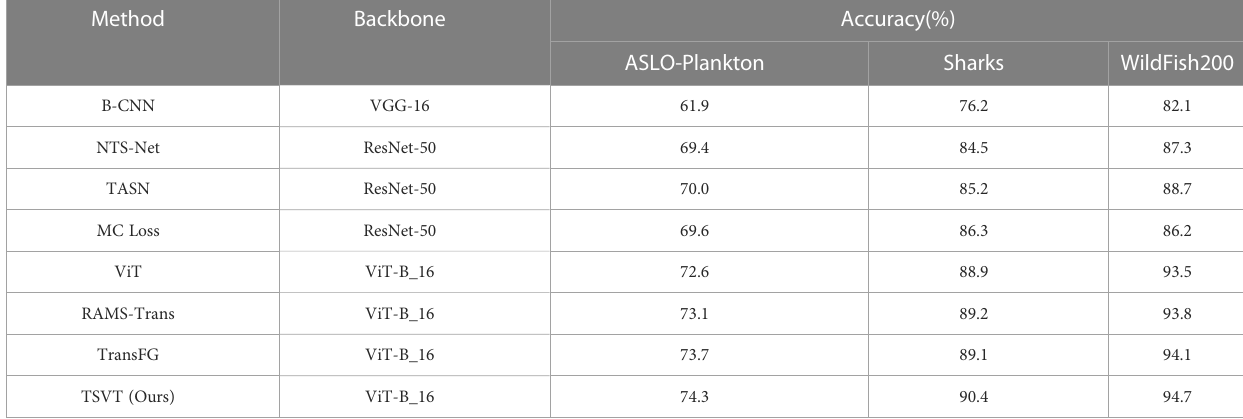
TABLE 2 Comparison of TSVT and state-of-the-art methods on three datasets of marine organisms. Method